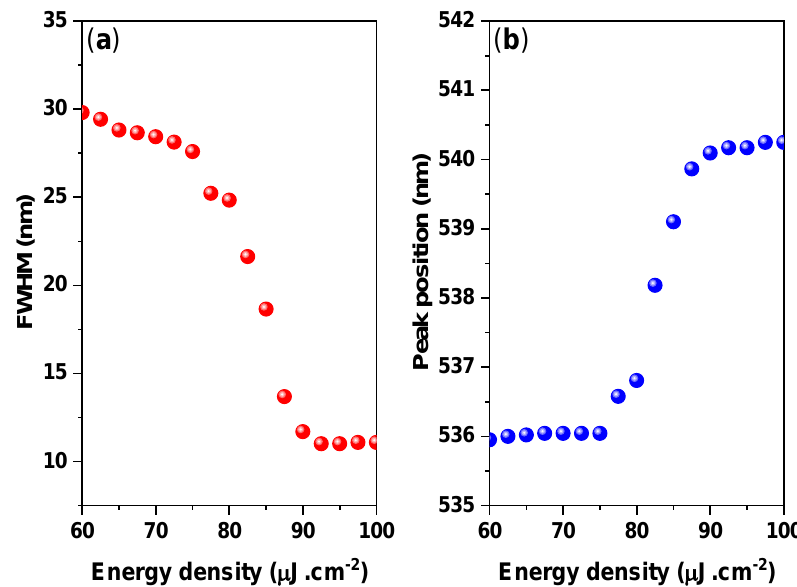
Figure 6. ( a ) FWHM and ( b ) ASE peak position versus energy density plot of the CsPbBr 3 / PMMA thin disk.